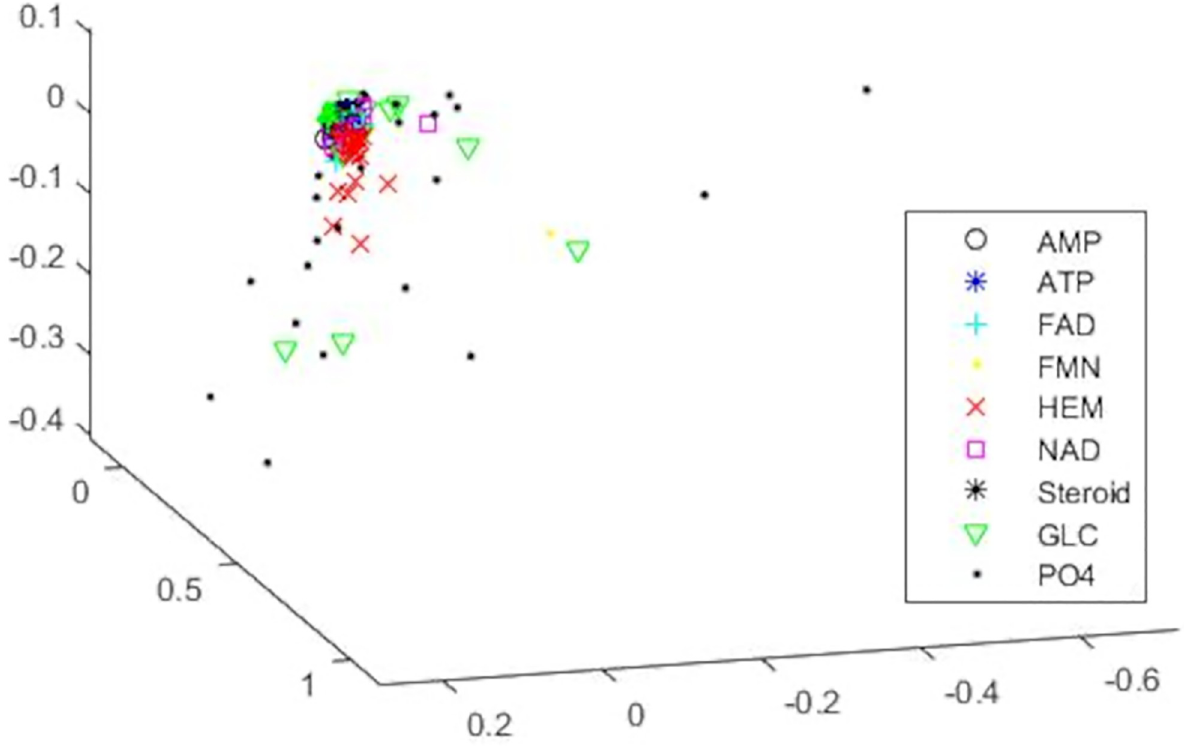
Fig 5. MDS plot in 3 dimensions for all ligand groups of the extended Kahraman dataset before cleaning the data. This multidimensional scaling plot visualizes the entire extended Kahraman dataset represented using CDPA in 3 dimensions. The binding sites are color-and-symbol coded according to the ligand they bind